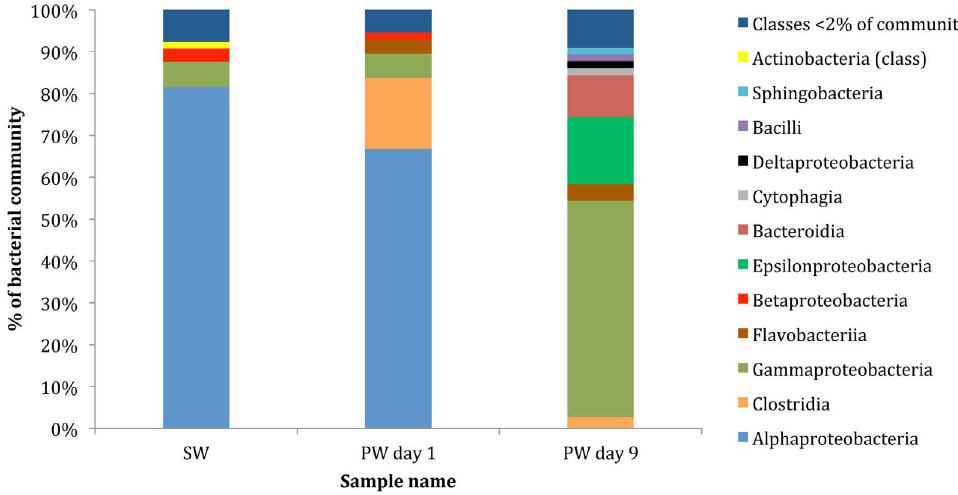
Figure 1. Class level affiliations assigned to contigs with predicted proteins and rRNA genes in source water (SW), produced water day 1 (PW day 1) and produced water day 9 (PW day 9). Total community includes Bacteria , Archaea , Viruses and Eukaryota .